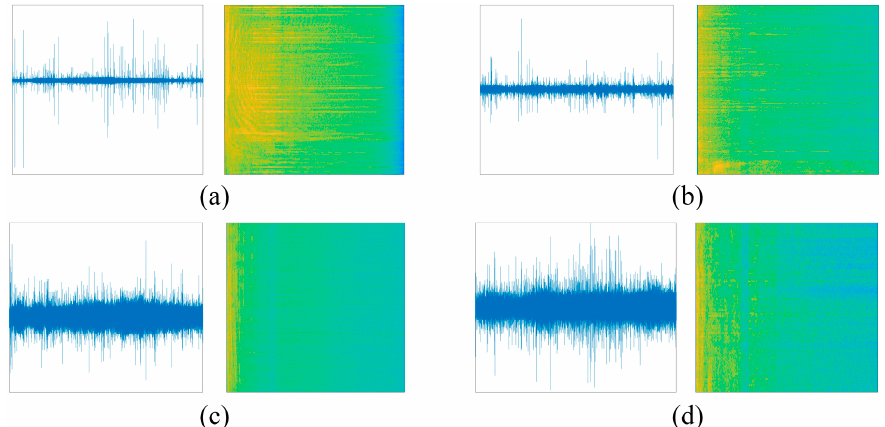
Figure 2. Comparison of the four LOFAR spectra with the original audio images. (( a ) Excerpt from underwater audio of Yate, ( b ) excerpt from underwater audio of pesqSaladinoPrimero, ( c ) excerpt from underwater audio of corriente, and ( d ) excerpt from underwater audio of Draga.)